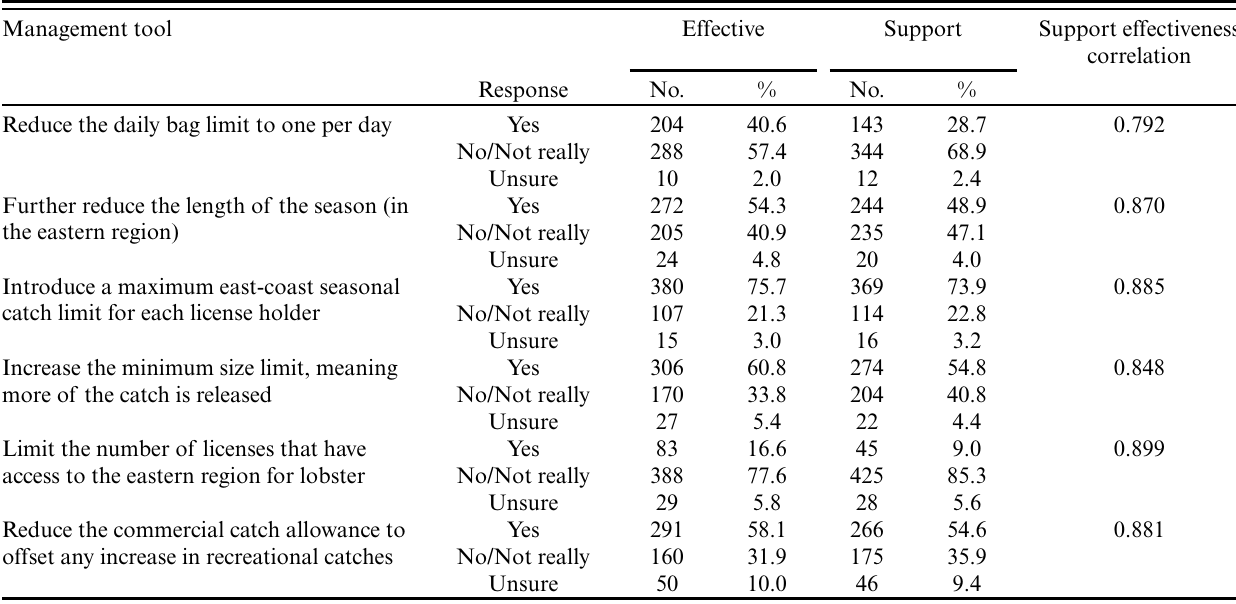
Table 2 . Fishers’ opinion on effectiveness and support of management tools. Management tool